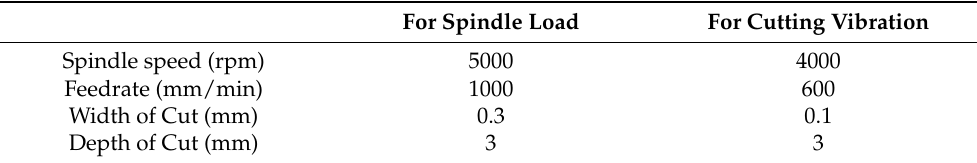
For Spindle Load For Cutting Vibration